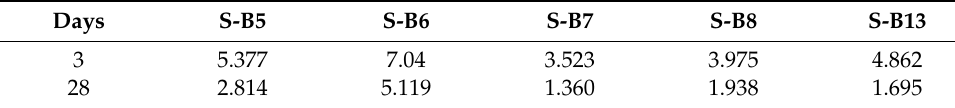
Figure 7. Pore size distribution of AA-FASM under seal-curing condition at ( a ) 3 days and ( b ) 28 days. Table 4. Porosity of AA-FASM under seal-curing condition (%). Table 4. Porosity of AA-FASM under seal-curing condition (%).